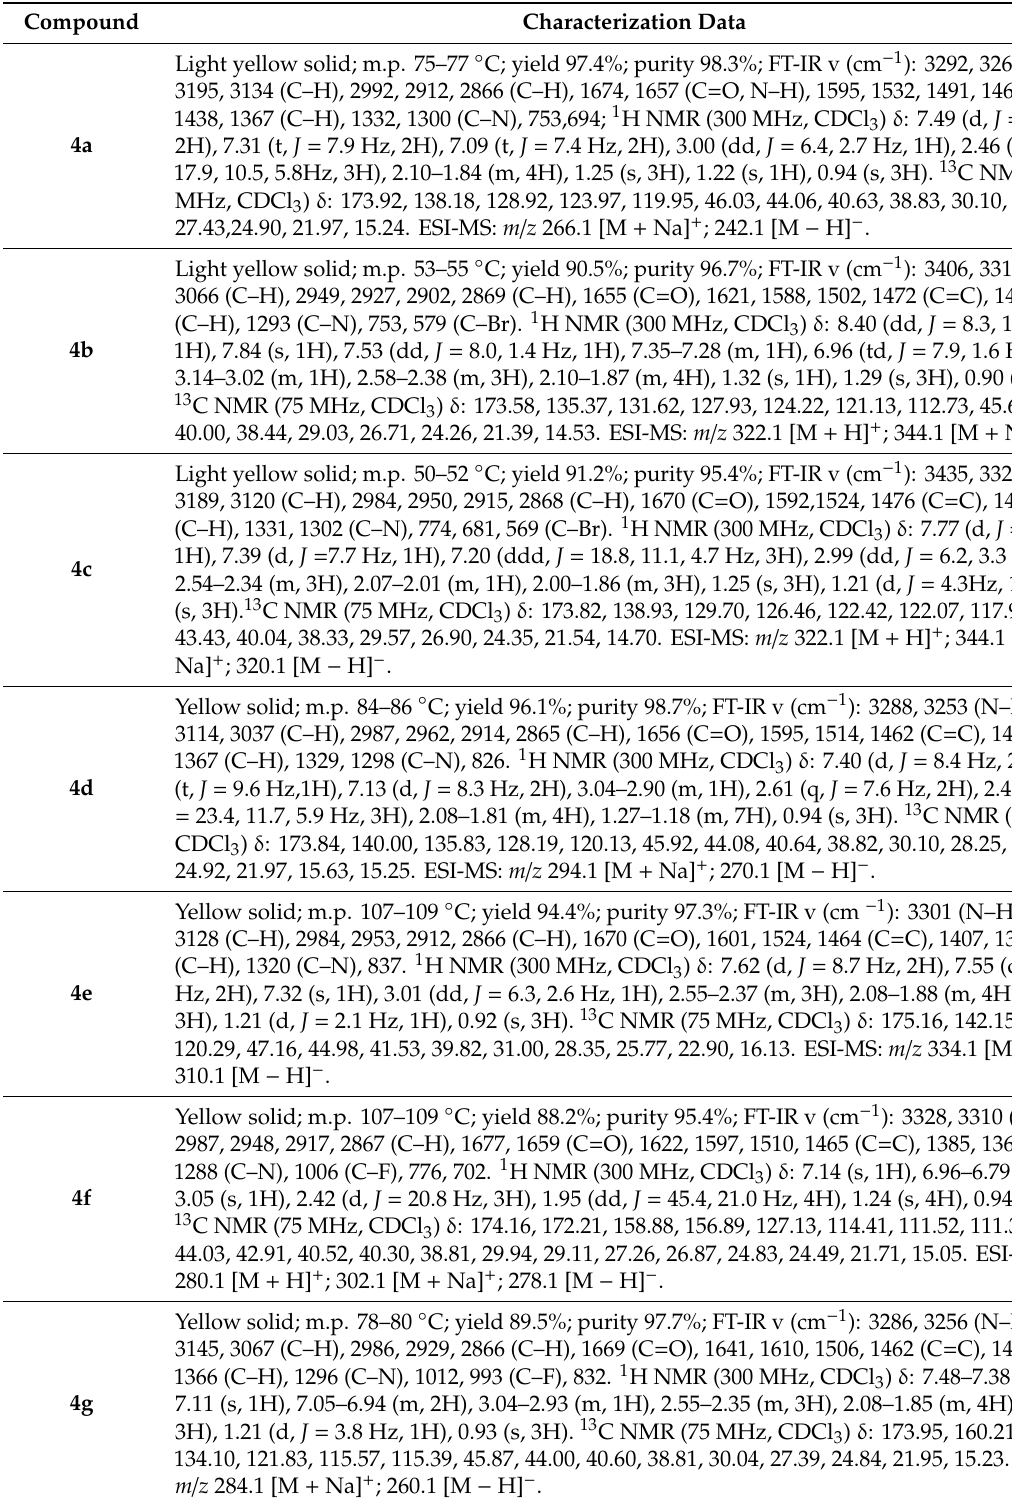
Table 4. Characterization data of N -ary-myrtanyl acid amides and N -(4-phenyl-thiazolyl-2-yl)-myrtanyl acid